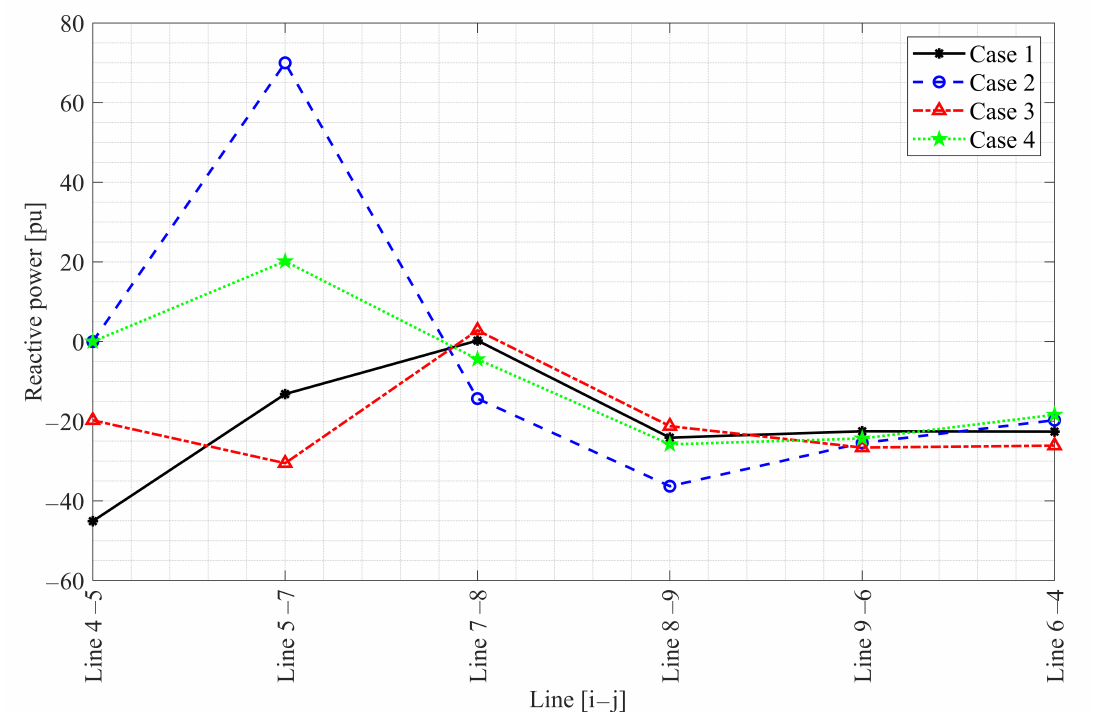
Figure 4. Reactive power flow in the 9-bus bar IEEE system.